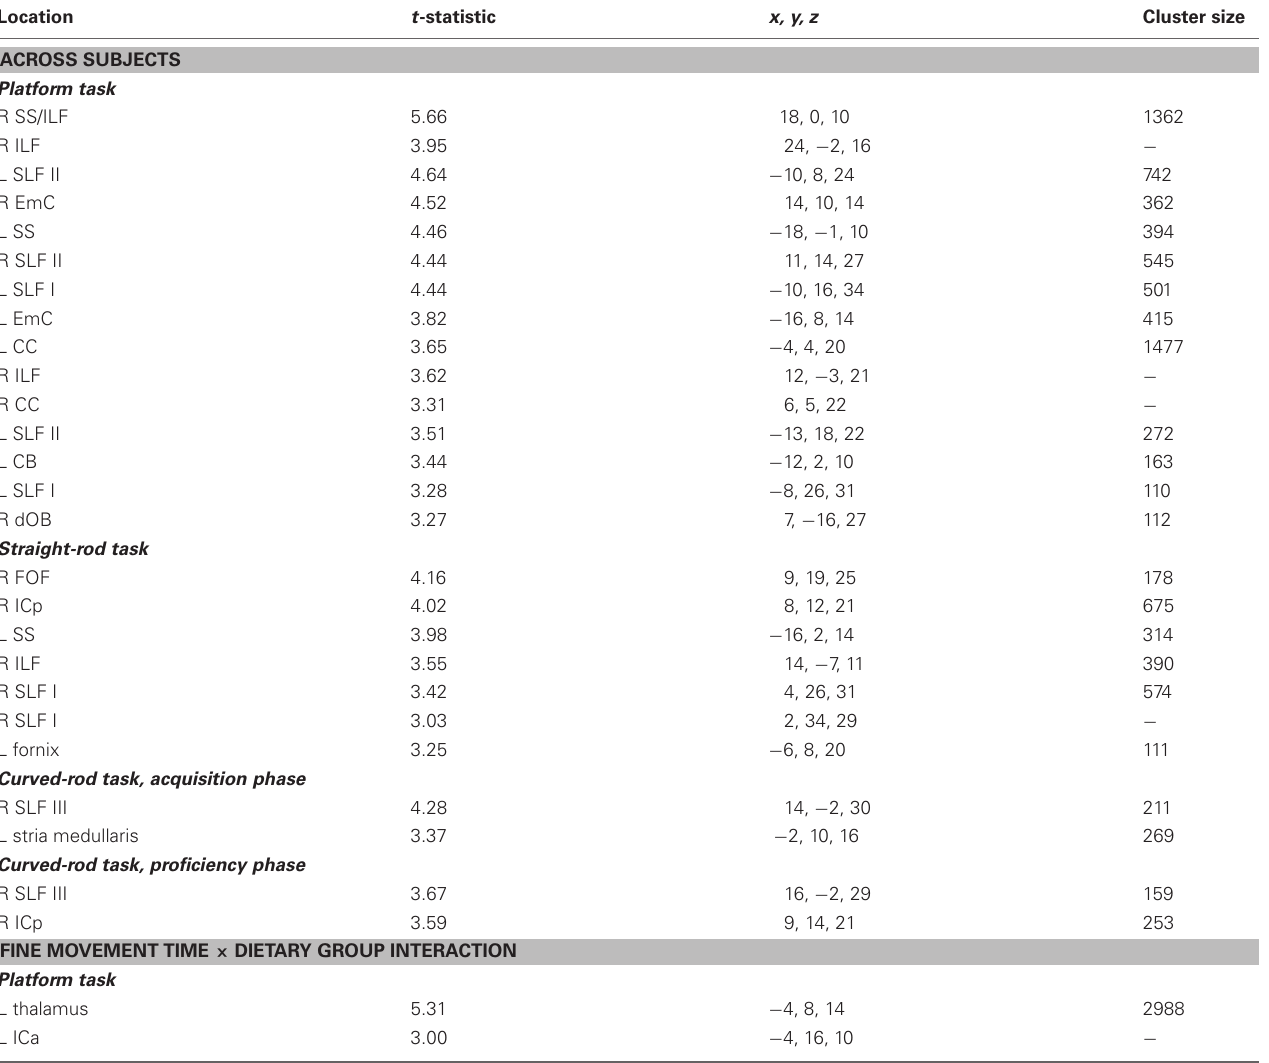
Table A4 | Regions where fine movement time was significantly correlated with fractional anisotropy in voxel-wise analyses across subjects and between dietary